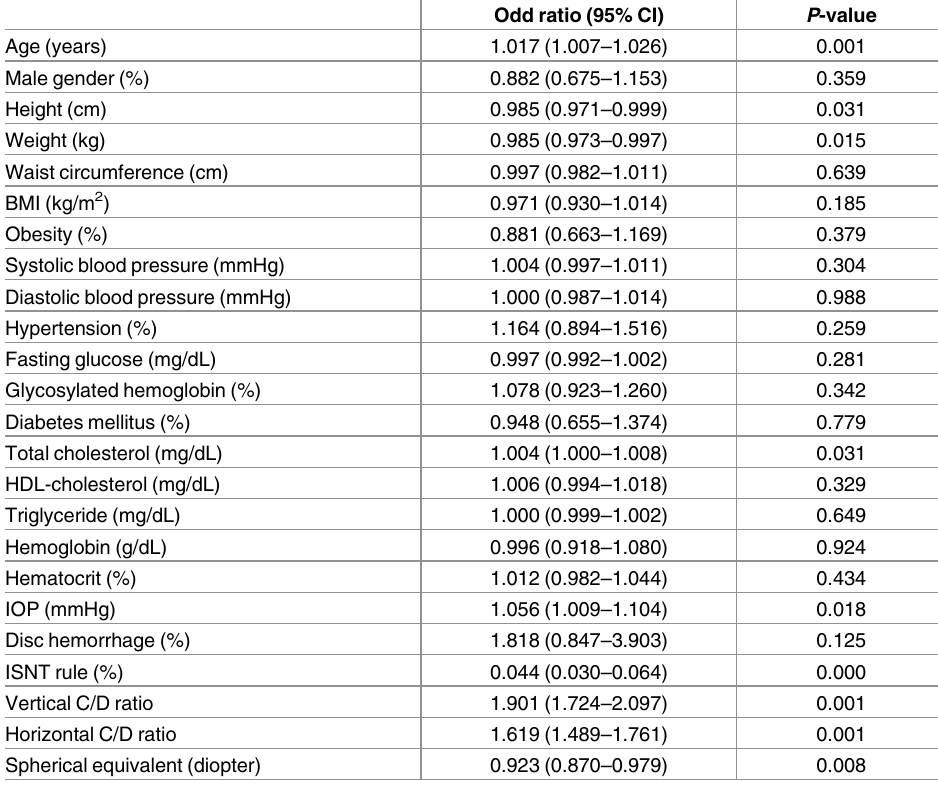
Table 6. Univariate regression analysis for systemicand ocular parameters in the glaucomatous reti- nal nerve fiber layer defect (RNFLD) group, using the non-glaucomatous RNFLD group as a reference.